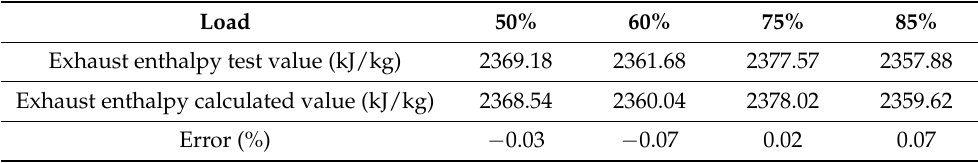
Table 1. Verification of final exhaust